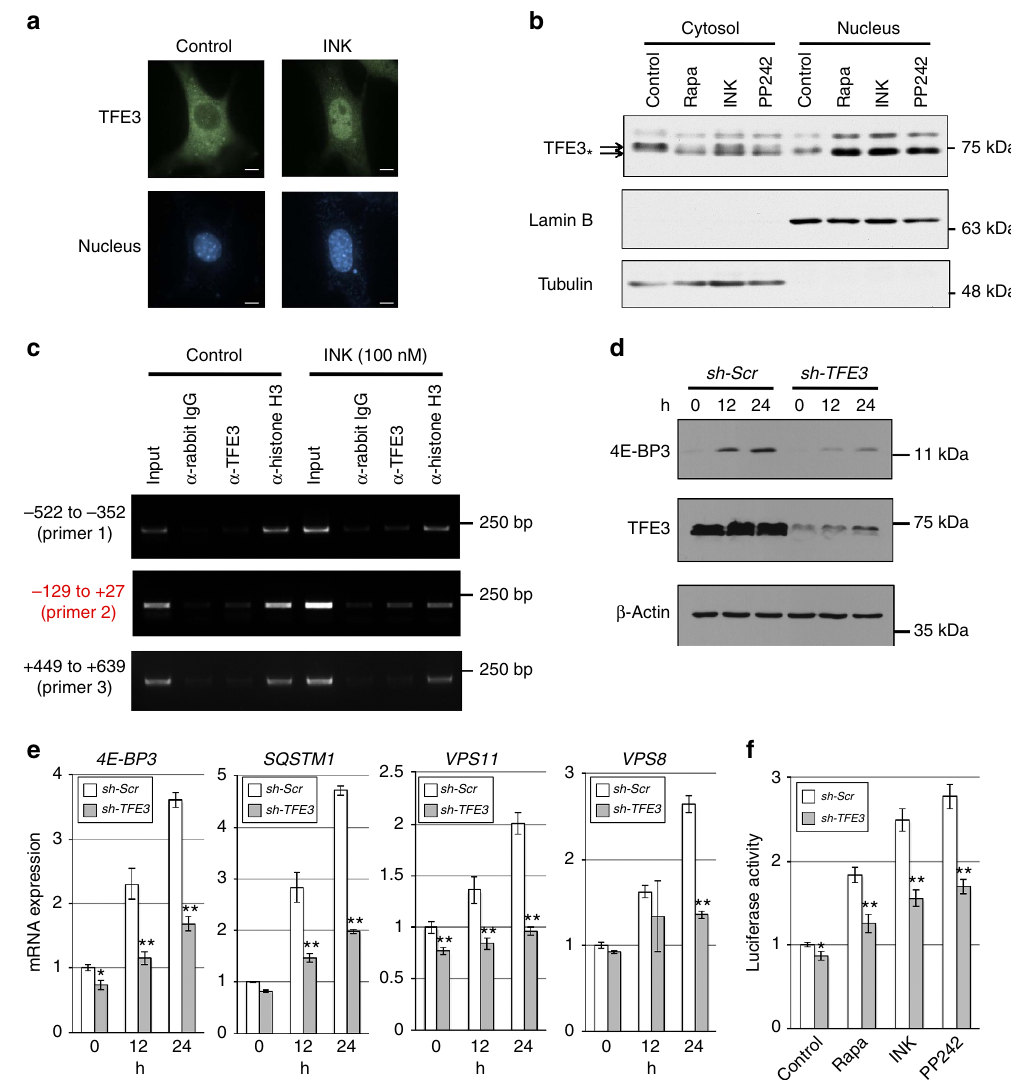
Figure 3 | TFE3 mediates the transcriptional induction of 4E-BP3 . ( a ) MiaPaCa-2 cells were treated with 100nM of INK1341 for 1h. The cells were fixed and endogenous TFE3 protein in cells was stained with anti-TFE3 antibody and Alexa-Fluor 488. Scale bar, 10 m m. ( b ) MiaPaCa-2 cells were treated with 100nM of INK1341 for 1h. Cells were lysed with a Dounce homogenizer. Nuclear and cytoplasmic fractions were separated by centrifugation. Protein levels were determined by immunoblotting. Arrow shows phosphorylated or dephosphorylated form (arrow with star). ( c ) Cells were treated with 100nM of INK1341 for 1h. Binding of TFE3 to the E-box region in EIF4EBP3 promoter was analysed by chromatin immunoprecipitation assay. ( d , e ) MiaPaCa-2 cells were transduced with scrambled (sh-Scr) or TFE3 shRNA (sh-TFE3). Protein and mRNA levels were determined by immunoblotting and real-time PCR analysis, respectively. mRNA levels were normalized against b -Actin. Error bars indicate ± s.d. ( n ¼ 3). * P o 0.05 and ** P o 0.01. Statistical significance was determined using two-way analysis of variance (ANOVA). ( f ) MiaPaCa-2 cells expressing scrambled or TFE3 shRNA were transiently transfected with reporter plasmids (p4E-BP3pro-Luc ( (cid:2) 163 to þ 59) plasmid and pRL-TK). After 24h, the cells were treated with rapamycin (100nM), INK1341 (100nM) or PP242 (1 m M) for 24h and then relative luciferase activity was determined as shown in b . Error bars indicate ± s.d. ( n ¼ 3). * P o 0.05 and ** P o 0.01. Statistical significance was determined using two-way ANOVA. A representative result of three ( a , b ) or two independent experiments ( c – f ) is cap-dependent translation activity at much higher level (Supplementary Fig. 16). 4E-BP1 KO cells sustained cyclin D3 protein level at the early time point, but not at the late time point (Fig. 5d,e). Thus, in accordance with its induction level, 4E-BP3 had a significant impact on translation at late time points of mTORC1 inhibition. For CCND3 mRNA levels, there was no significant difference between the cells, although the mRNA level was reduced in response to treatment with asTORi (Fig. 5f).